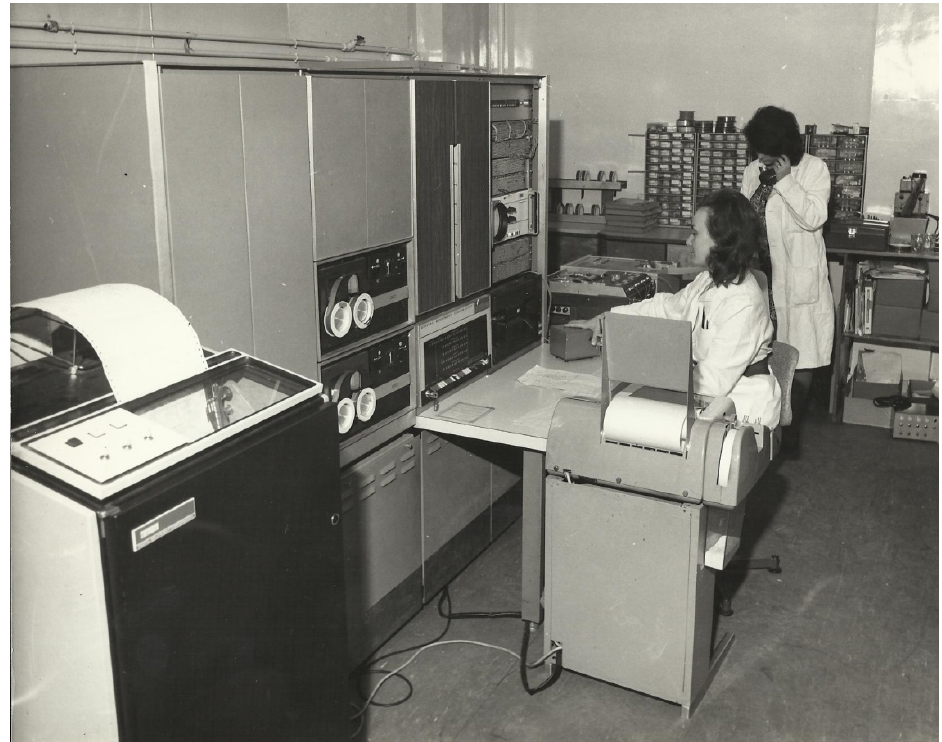
Figure 2. The first automated ECG interpretation system in operation in Glasgow Royal Infirmary around 1971. One technician controlled the tape recorder and listened to the patient details which were also recorded. The second technician monitored the three orthogonal lead ECG on the oscillo- scope and started the analogue to digital conversion. The software was stored on the small digital tapes (DECtapes) and retrieved as necessary.